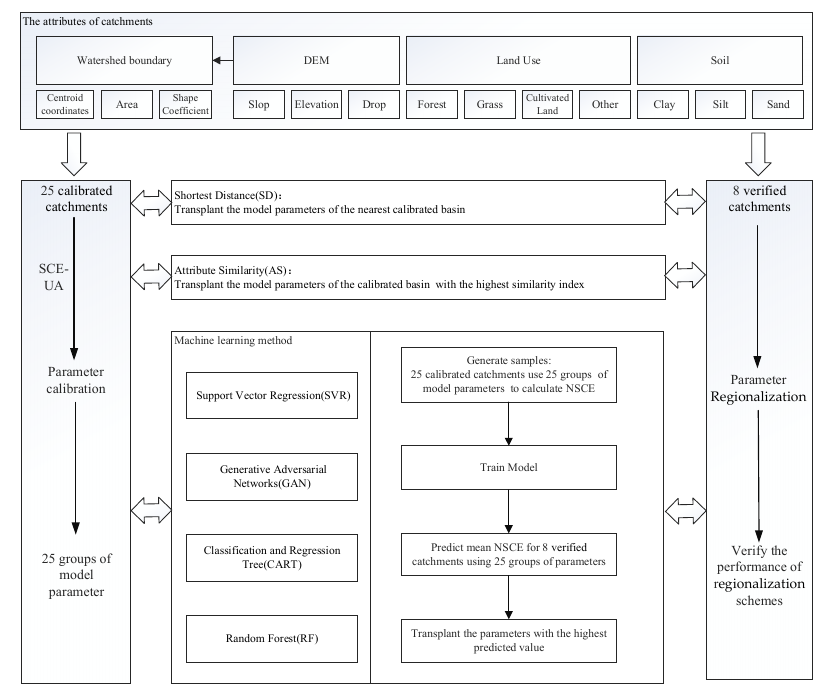
Figure 5. Flow of parameter regionalization method.